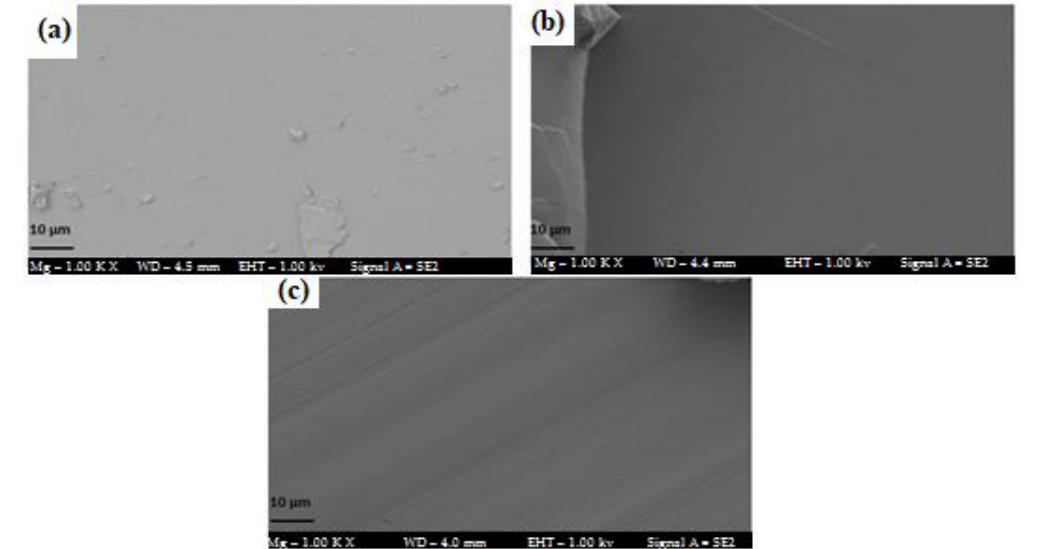
Figure 8. FESEM micrographs of PUs synthesized at 100 × . ( a ) P.1; ( b ) P.2; ( c ) P.3.